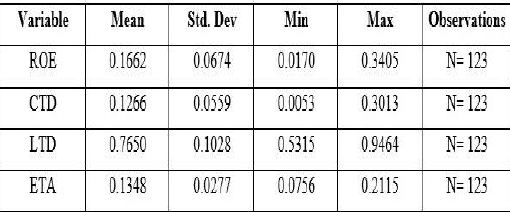
Table 1: Variables’ Descriptive Statistics